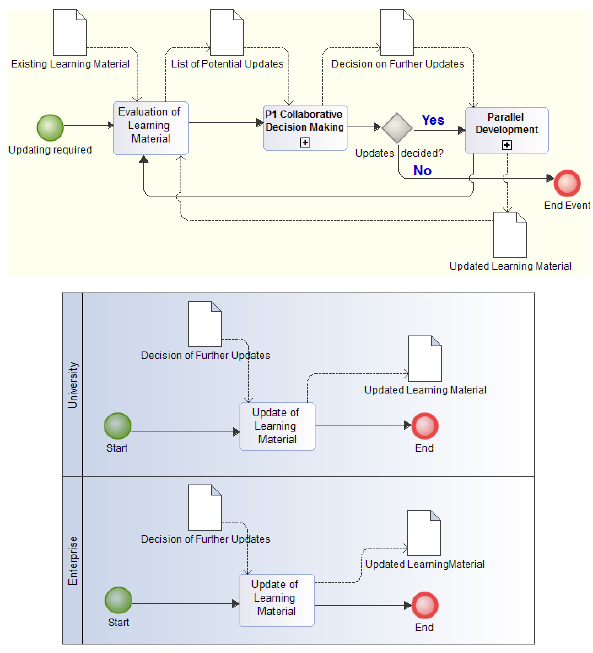
Figure 3. BPMN diagrams for the process Shared Development of Learning Material (top) and its sub-process Parallel Development (bottom) (source: Minghini and Brovelli,